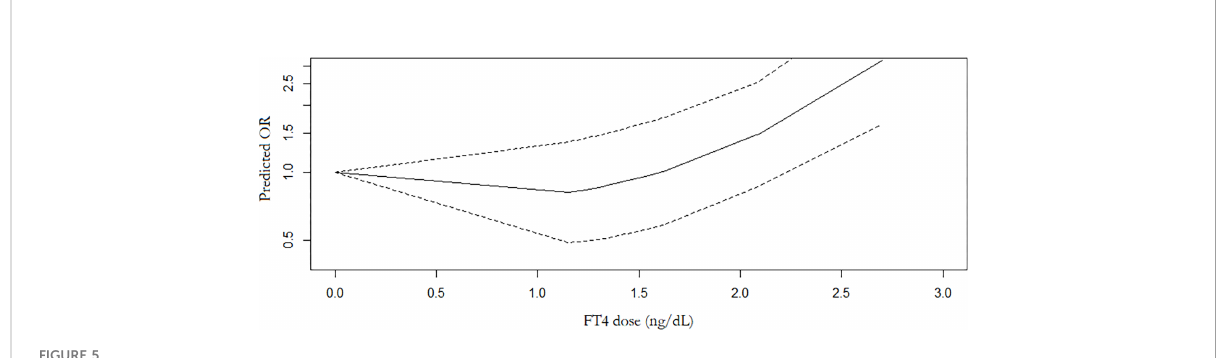
FIGURE 5 Dose response relationship between FT4 level and TC